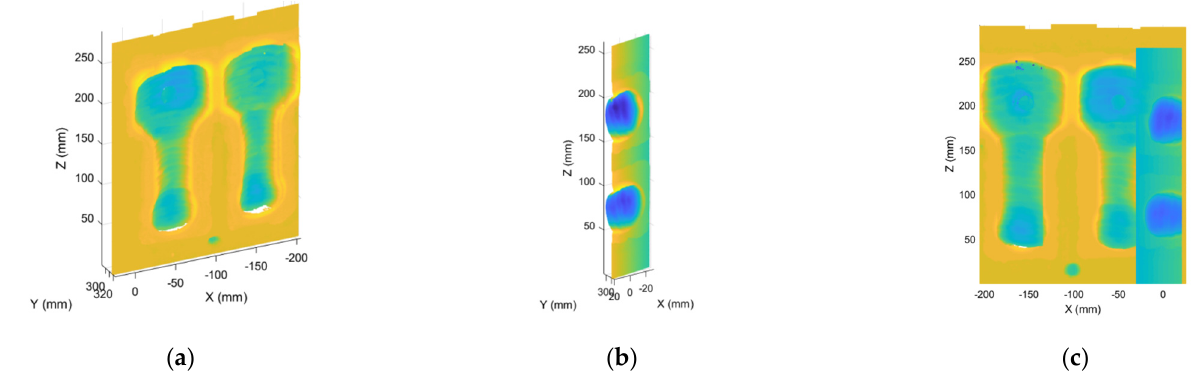
Figure 2. The relative position of the missing point cloud part. ( a ) Initial registration image; ( b ) the missing part; ( c ) initial relative position.